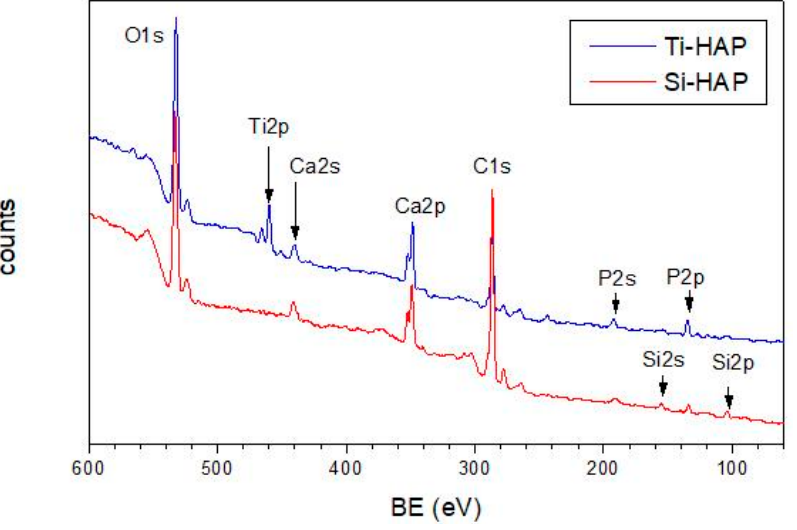
Figure 1. Wide-scan XPS spectra of the pristine Ti-HAP and Si-HAP samples in the 60–600 eV range. Table 2. Photoemission peaks of the HAP samples.